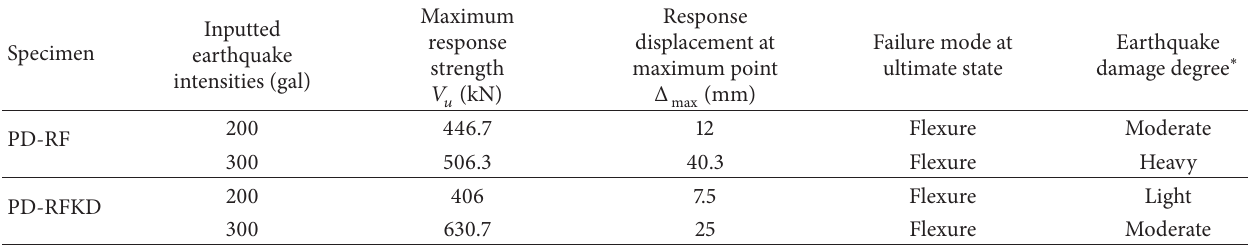
Table 6: Comparisons of response strength, response displacement, and earthquake damage degree following the pseudodynamic test.